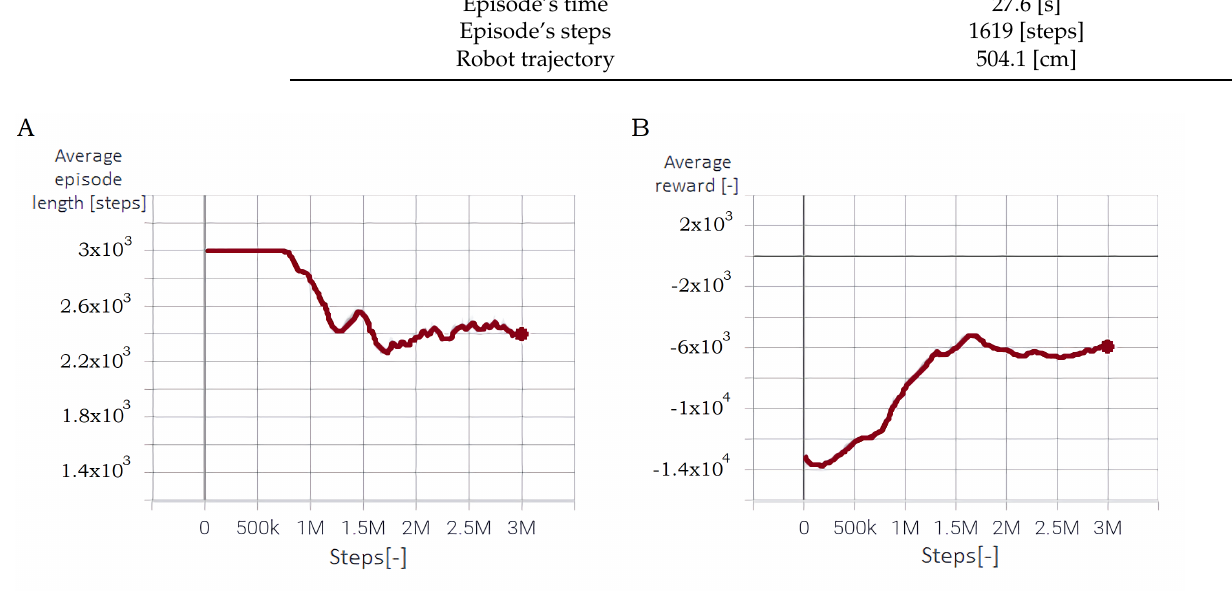
Figure 8. Function of the study case: ( A ) Average episode length, ( B ) Average